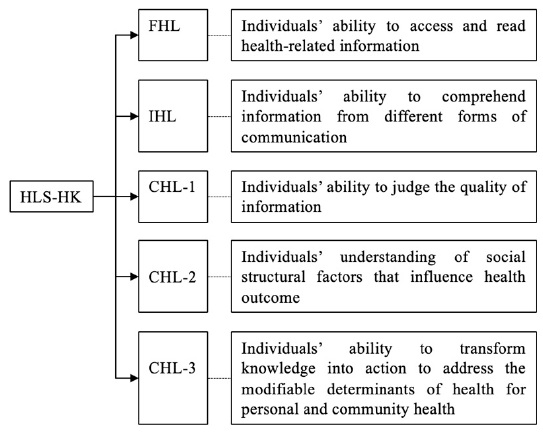
Figure 1. Theoretical framework of HLS-HK. (Note: Abbreviations: HL: health literacy; FHL: functional health literacy; IHL: interactive health literacy; CHL-1: the first subdomain of critical health literacy; CHL-2: the second subdomain of critical health literacy; CHL-3: the third subdomain of critical health literacy; HLS-HK: Hong Kong Health Literacy